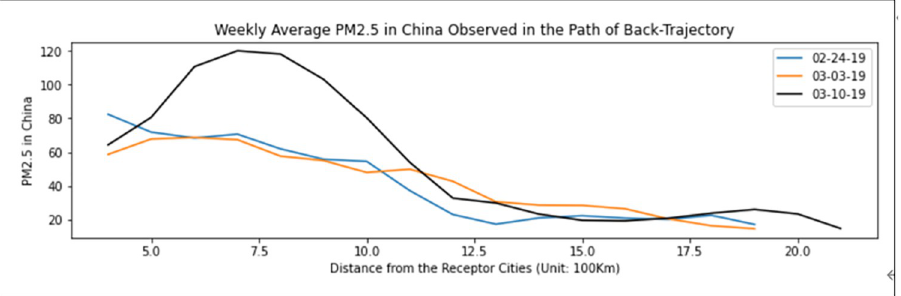
Fig 2. Weekly average PM 2.5 concentrations observed in Chinese cities in the pathways of backward trajectories by the distance to the receptor cities in Korea.